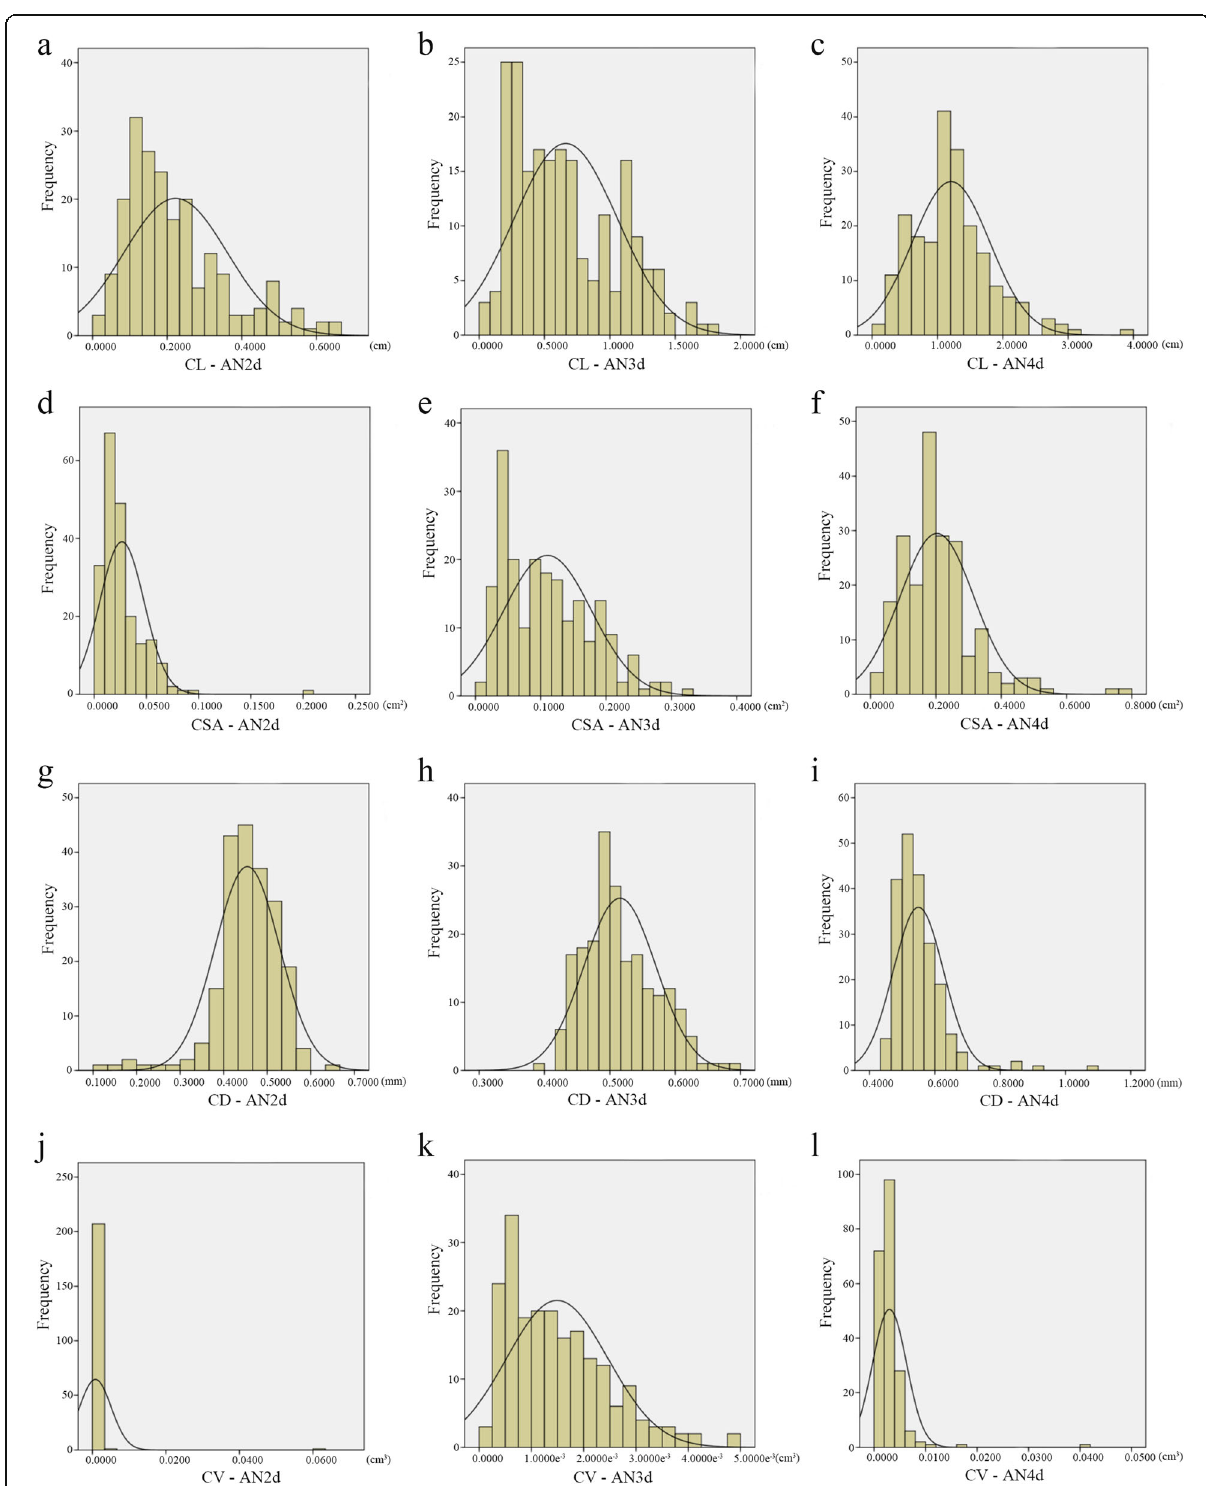
Fig. 2 Frequency distribution histogram of each phenotype of coleoptile at different submergence time points. Note: CL, coleoptile length; CSA, coleoptile surface area; CD, coleoptile diameter; CV, coleoptile